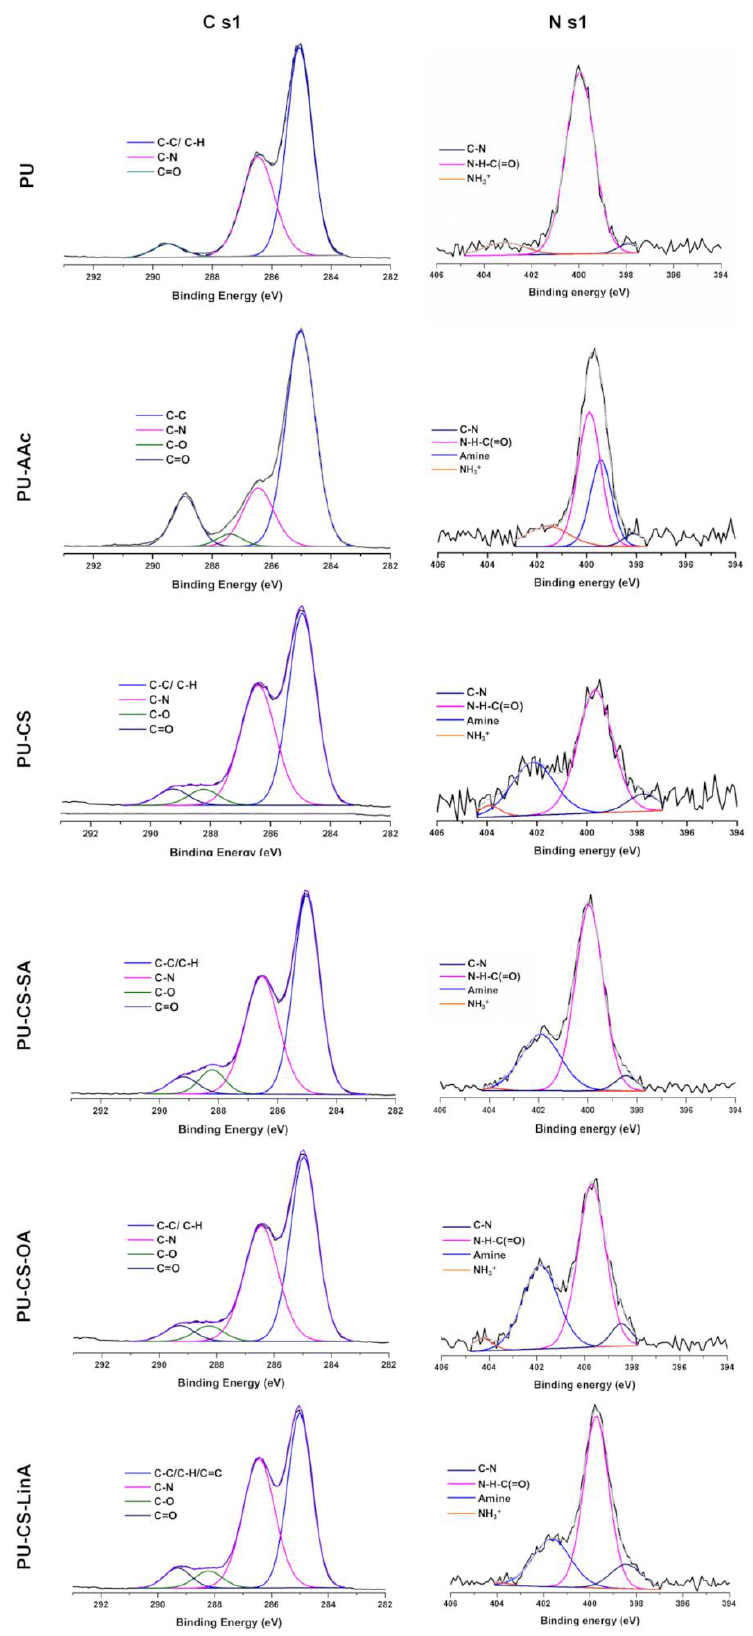
Figure 7. X-ray photoelectron spectroscopy C 1s and N 1s region scans of untreated and coated PU stents.